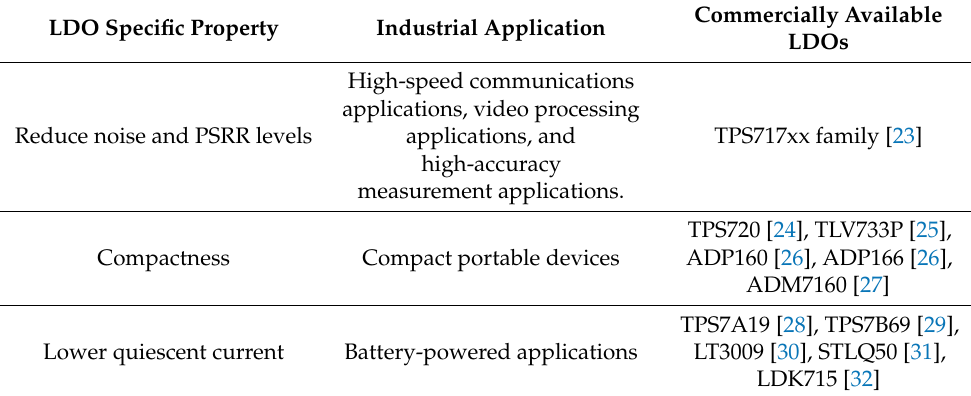
Figure 5. Basic quiescent current of typical LDOs [21]. Table 3. Commercially available LDOs for specific